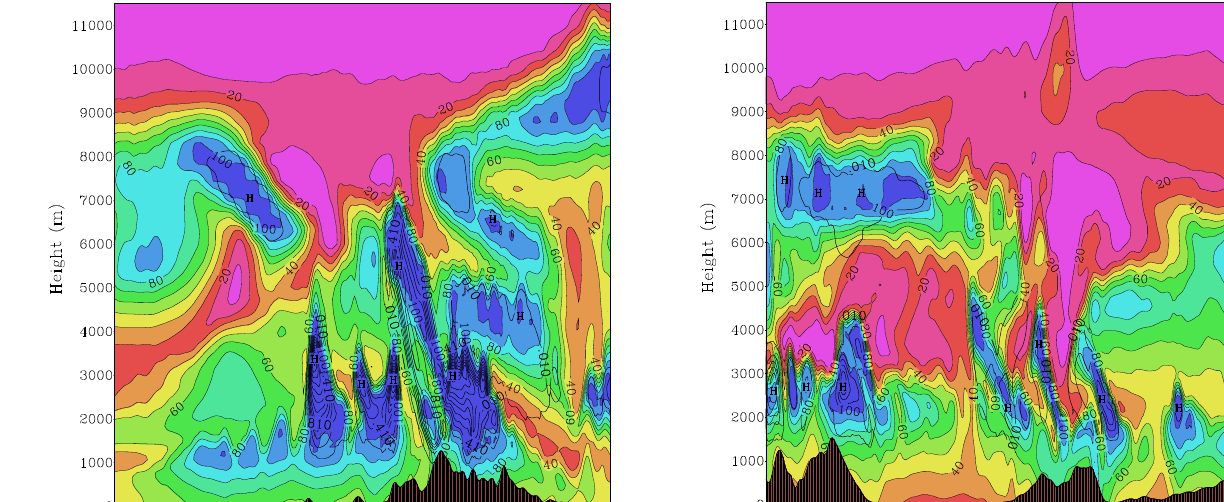
Fig. 11. Same as Fig. 9 on section y1 at 10:30 UTC.